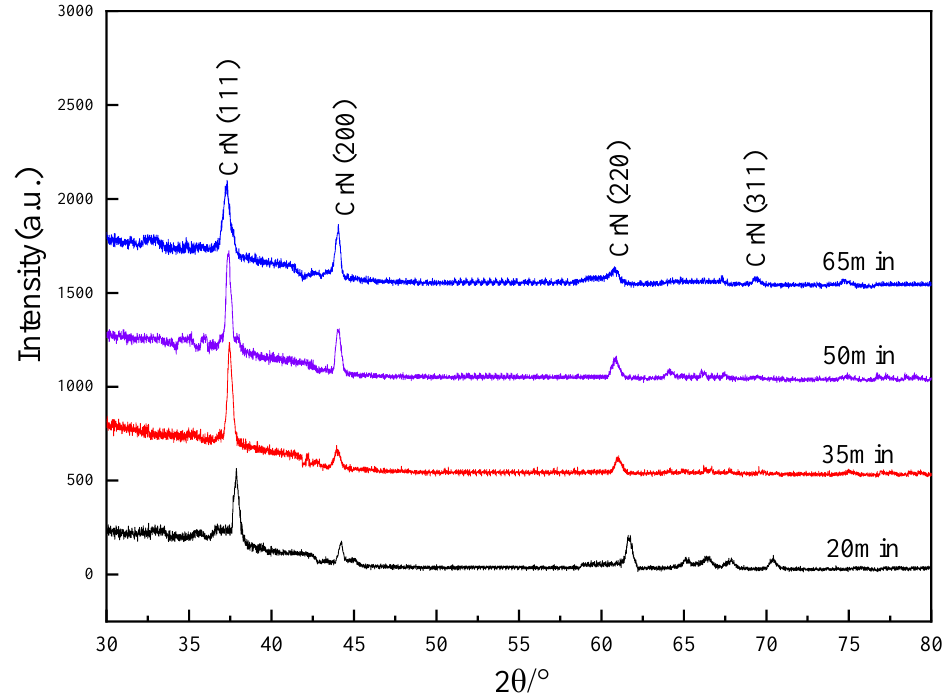
defects decreases further, and the coating is complete and continuous. After sputtering and the surface shows black contaminants of irregular size and shape, mainly from the Cr target, or from residual organic solutions from the preprocessing of the AZ31. The TR210 handheld roughness tester (accuracy: 10 nm) shows that the average roughness of the coating is 23.5 nm, 25.7 nm, 27.9 nm, and 29.1 nm, respectively, indicating that the surface roughness reduces with an increase in coating thickness.